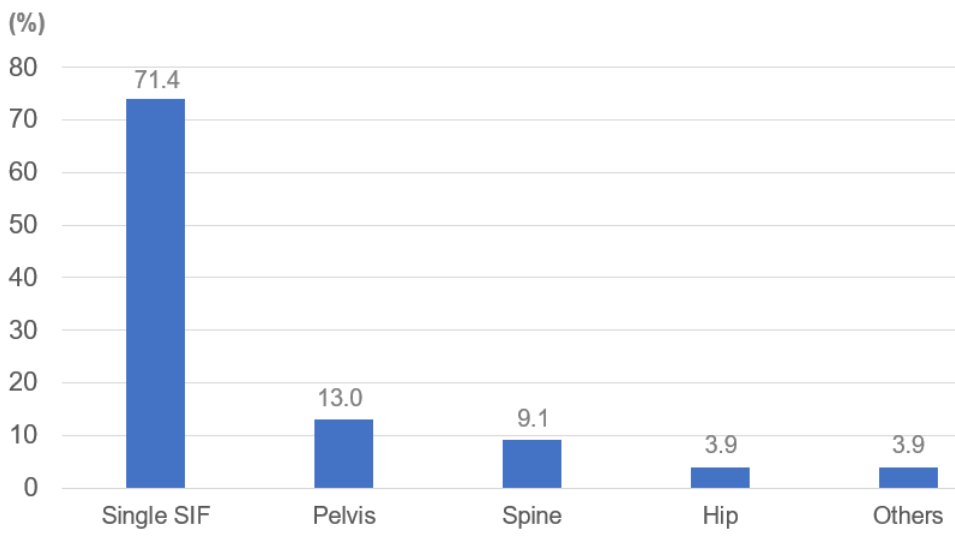
Figure 5. Other fracture.